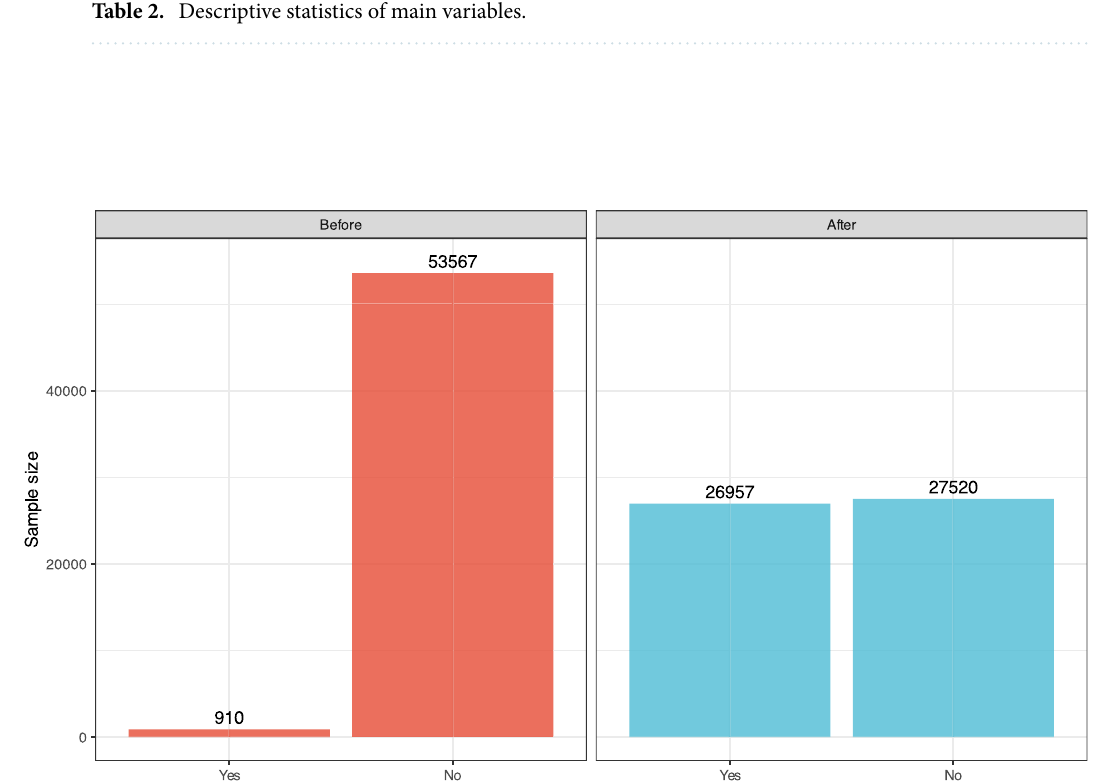
Table 2. Descriptive statistics of main variables.